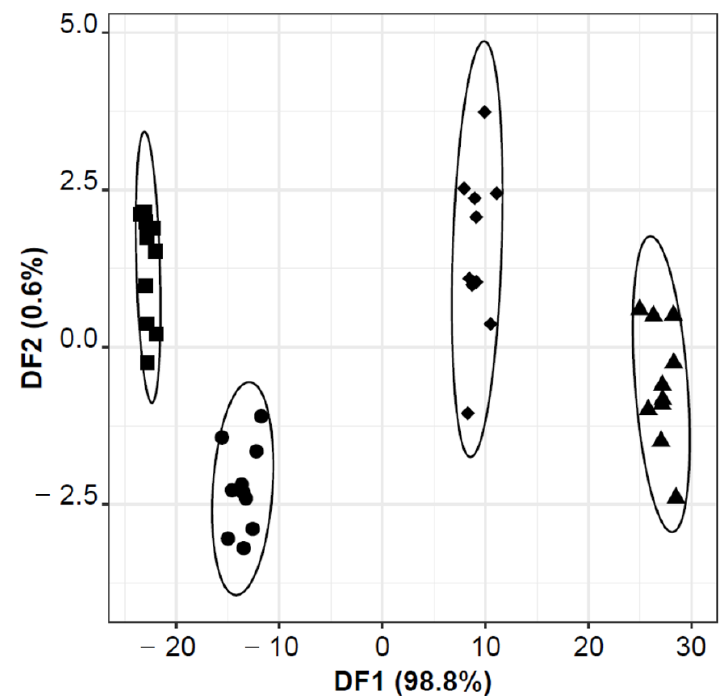
Figure 1. E-nose-MOS-LDA- SA model’s discrimination of the four studied Gram -positive and Gram-negative bacteria grown in BHI agar medium: ( ▲ ) E. faecalis ; ( ♦ ) S. aureus ; ( ■ ) E. coli ; and, (●) P. aeruginosa . Classification model based on 25 feature extraction MOS signal parameters (S6_LP,